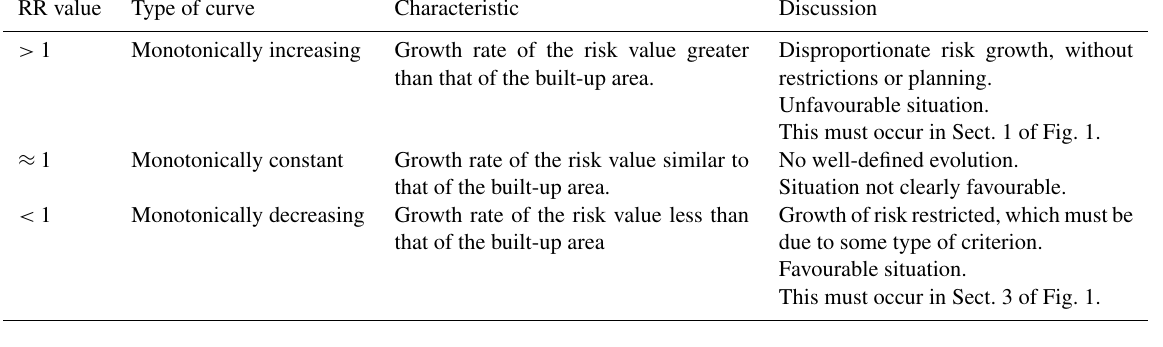
Table 1. Characteristics of the risk ratio (RR).